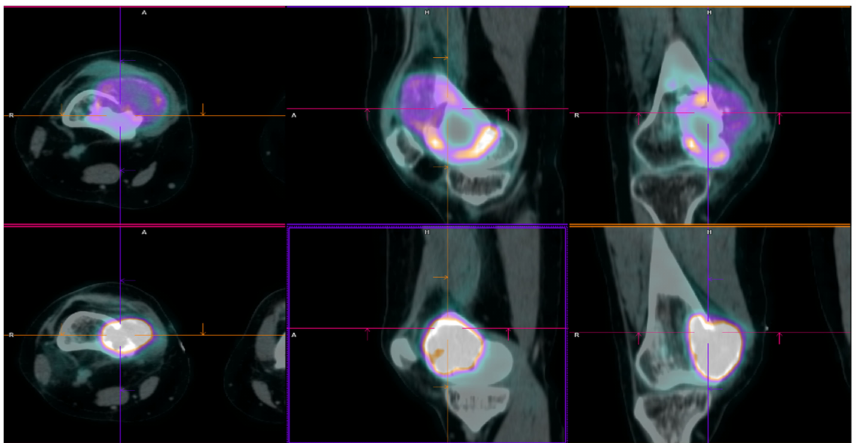
Figure 1. 18 F-FDG PET/CT axial ( left ), sagittal ( middle ) and coronal ( right ) fused view of right knee in patient no. 1. The first PET/CT performed at time of first relapse of GCTB (lower row) showed a focal area of intense FDG uptake (SUVmax = 21) corresponding to a lytic lesion of the medial meta-epiphyseal aspect of the right femur, showing extension to the neighbouring soft tissue. A second PET/CT scan (upper row), showed a disease relapse with an FDG avidity lower than original lesion (SUVmax = 11). A = anterior; R = right; H = high.